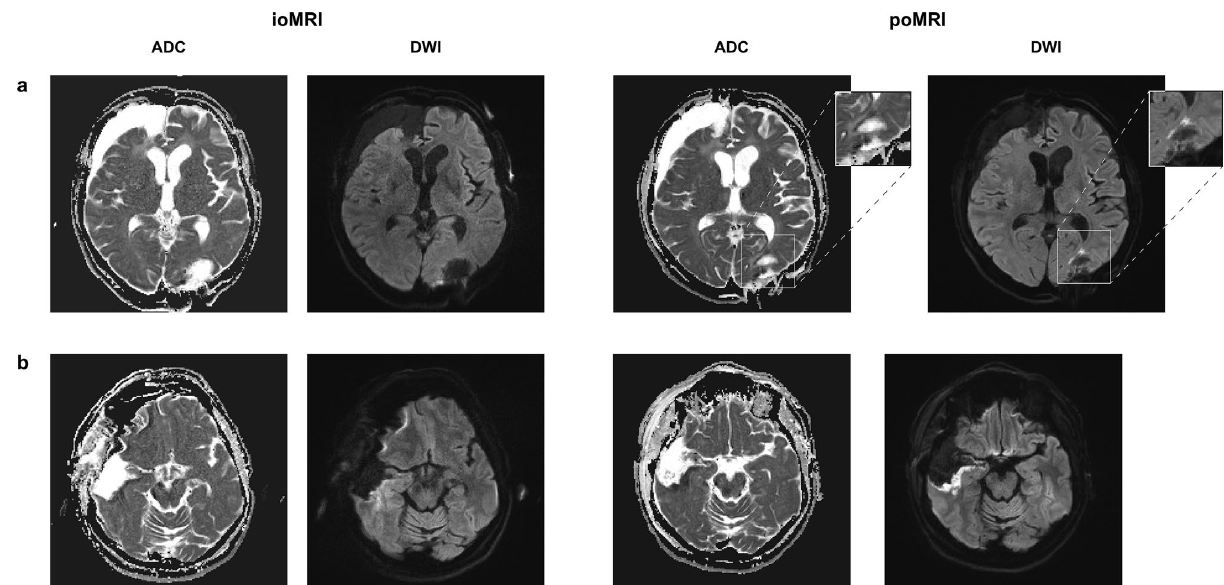
Figure 3. Illustrative case examples. ioMRI (left) and poMRI (right) of two representative cases: (a) Case 3 (patient #5). (b) Case 4 (patient #8). ioMRI intraoperative MRI, poMRI postoperative MRI, ADC apparent diffusion coefficient image, DWI diffusion-weighted